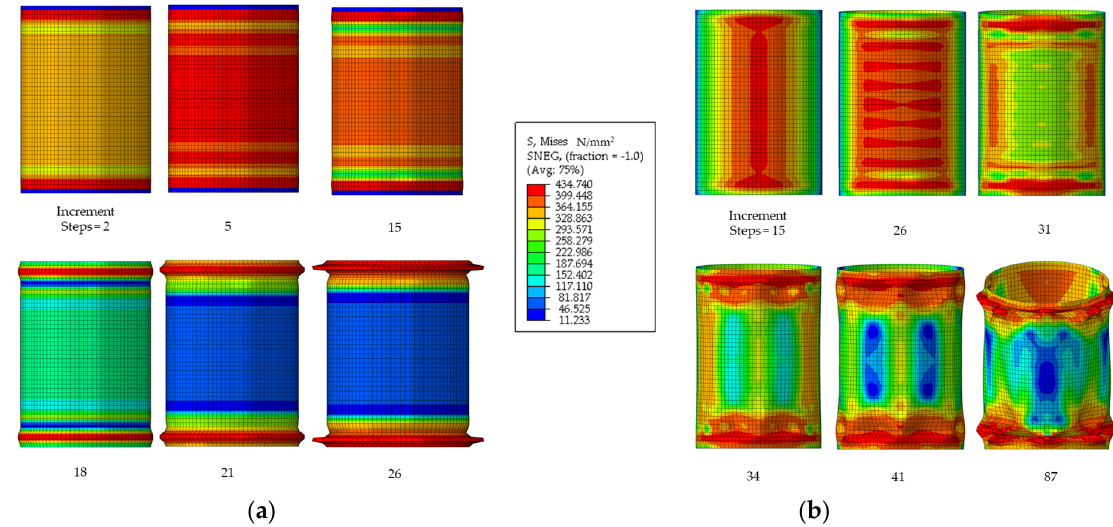
Figure 17. Shell (9 m at 24 mm) surface deformation and stress distribution under axial compressive load ( a ) and under the pure bending moment ( b ), the scale factor is 5.